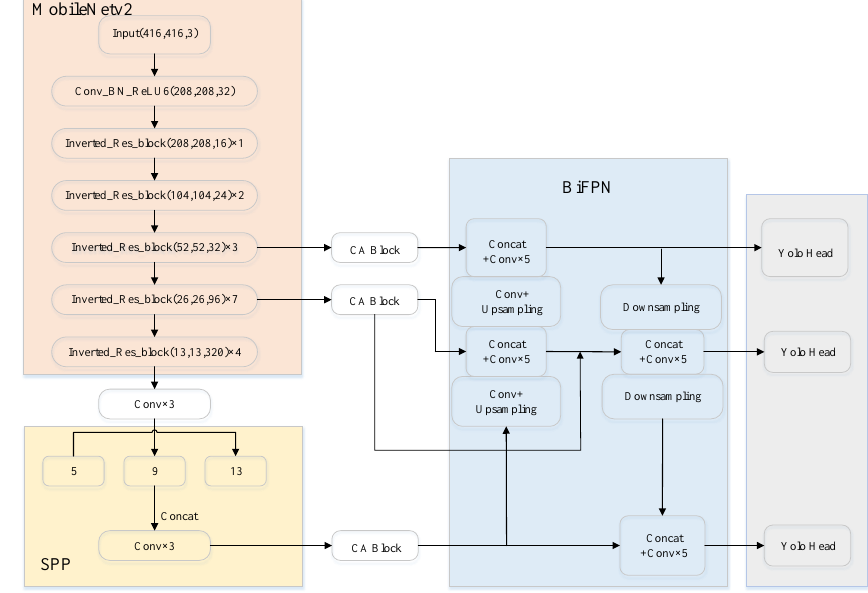
Figure 6. Model structure of CA-MobileNetv2-YOLOv4.